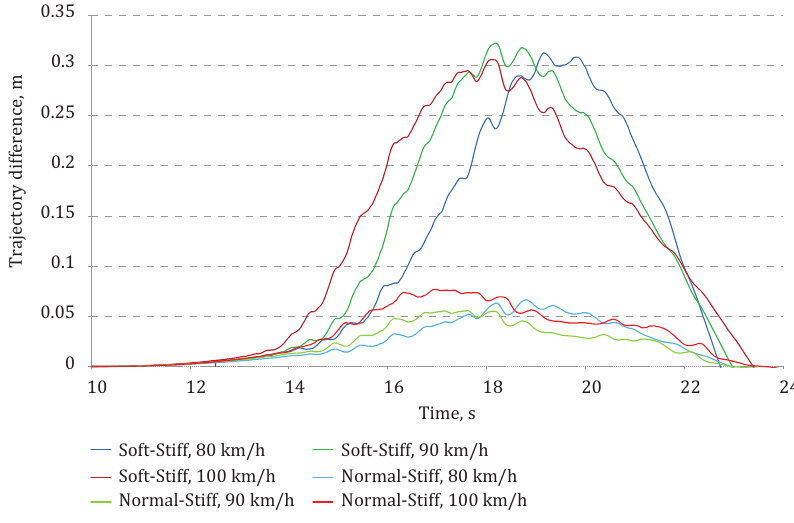
Figure 8. Trajectory differences with different suspension damping modes and driving speeds on D class road for the right